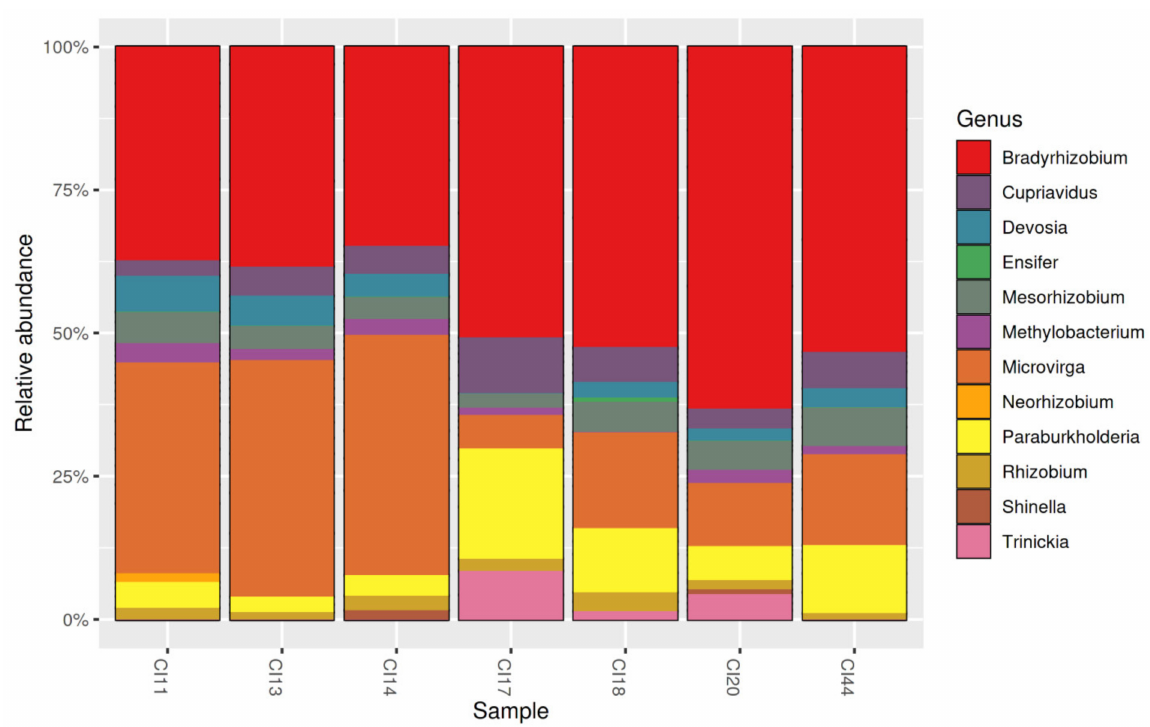
Figure 4. The relative abundance of the 12 genera of rhizobia detected from the savannah soils in Northern C ô te d’Ivoire. CI11: soil from the locality of Kokpingu é ; CI13: Doropo; CI14: Ouangolo; CI17: Kalogokaha; CI18: Kanawolo; CI20: Ka-tiola; CI44: